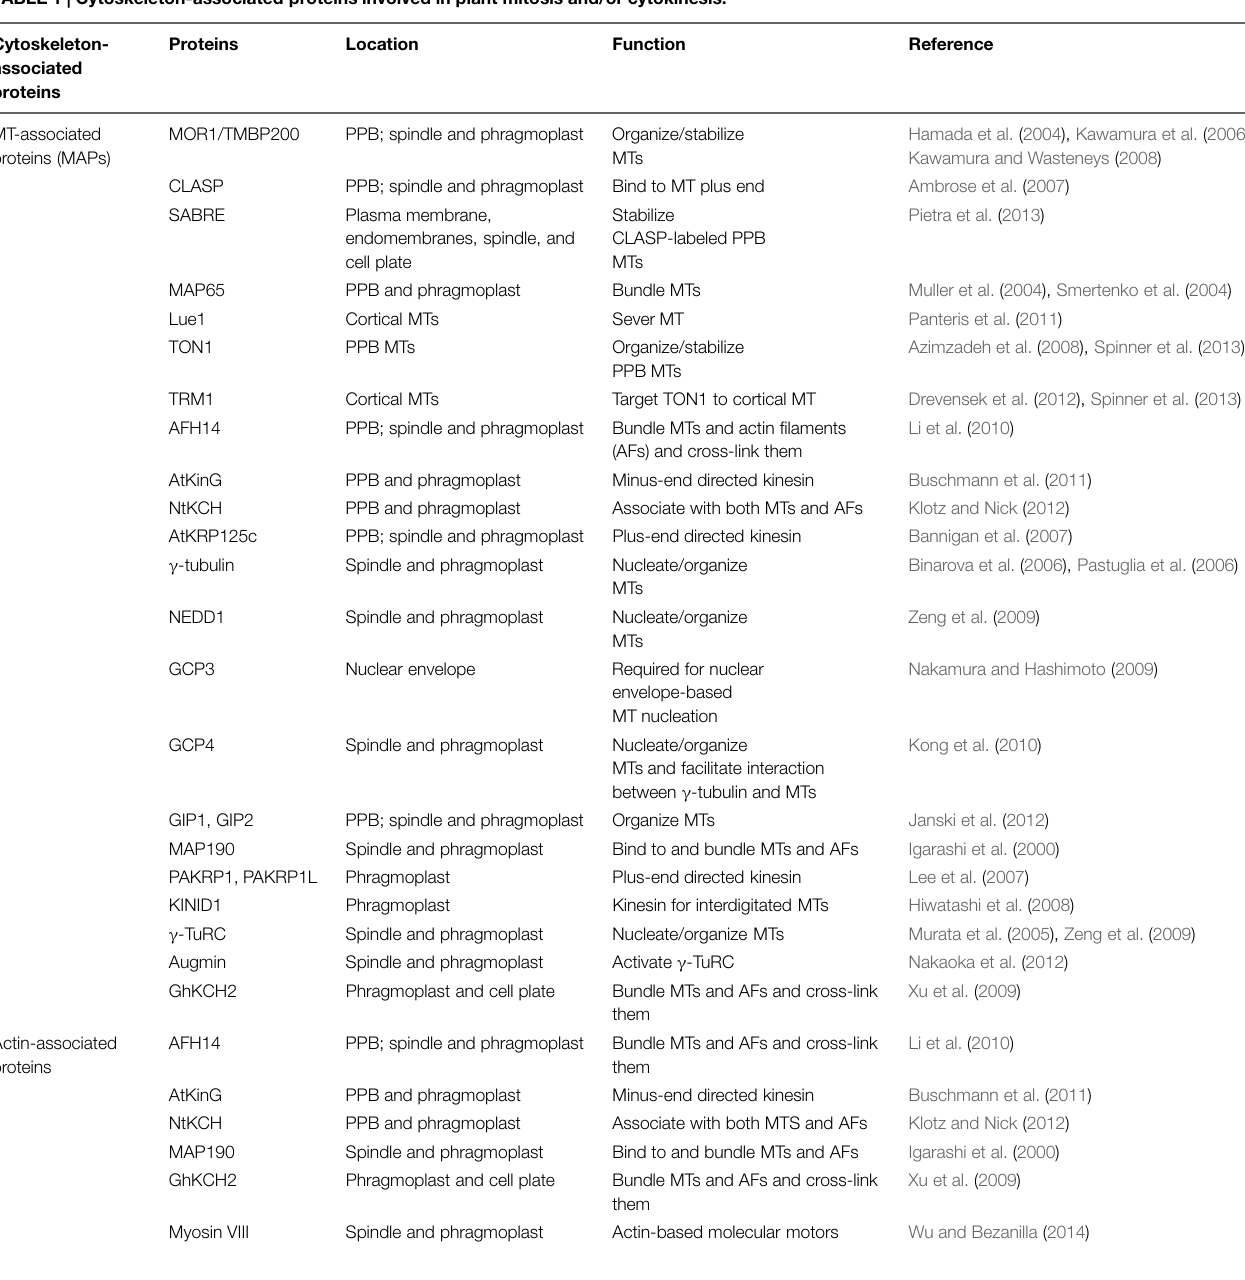
TABLE 1 | Cytoskeleton-associated proteins involved in plant mitosis and/or cytokinesis. Cytoskeleton- associated proteins